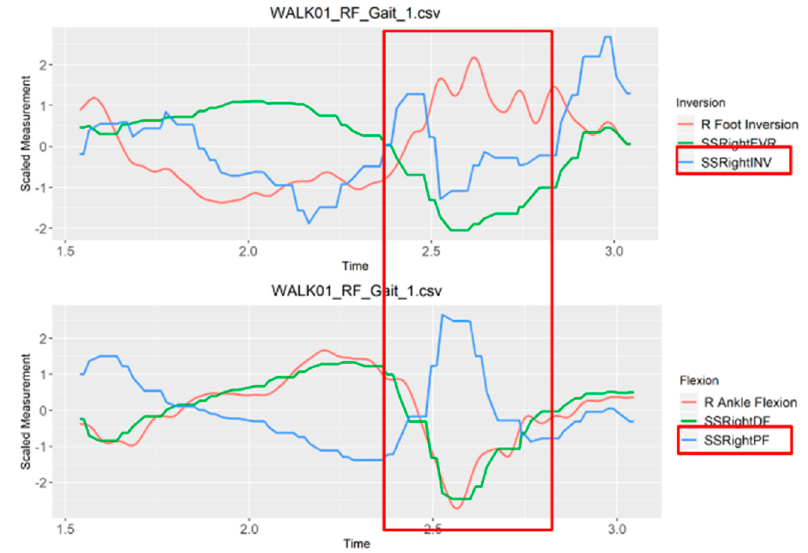
Figure 9. Sample participant data demonstrating a coupling effect between INV and PF sensors of the right foot. PF is causing a decrease in the inversion value because tension is being taken off the INV SRS during the gait movement. Therefore, as PF increases, INV incorrectly decreases due to this coupling effect.